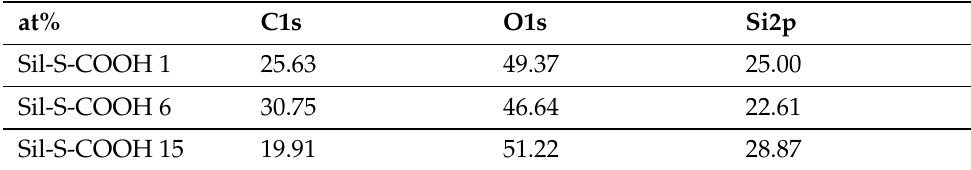
Table 2. Surface elemental composition of carboxylic acid-containing samples determined by X-ray photoelectron